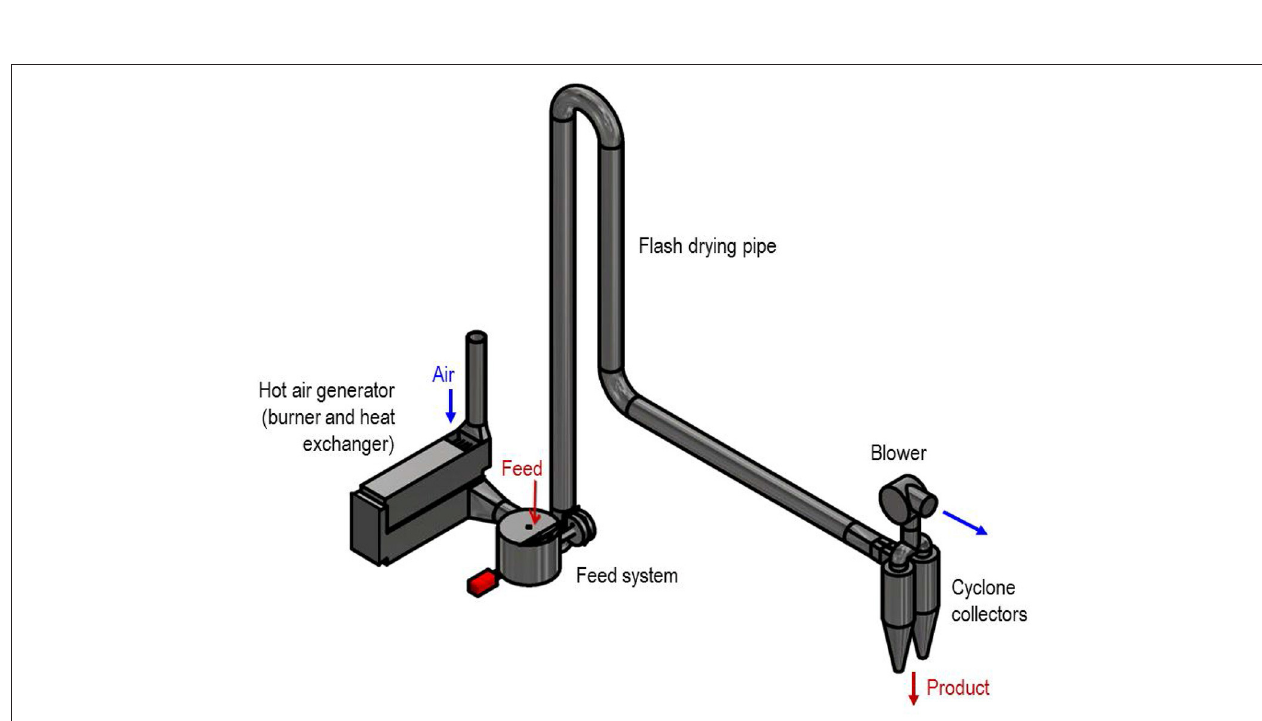
FIGURE 5 | Key components common to all flash dryer designs (source: Authors).